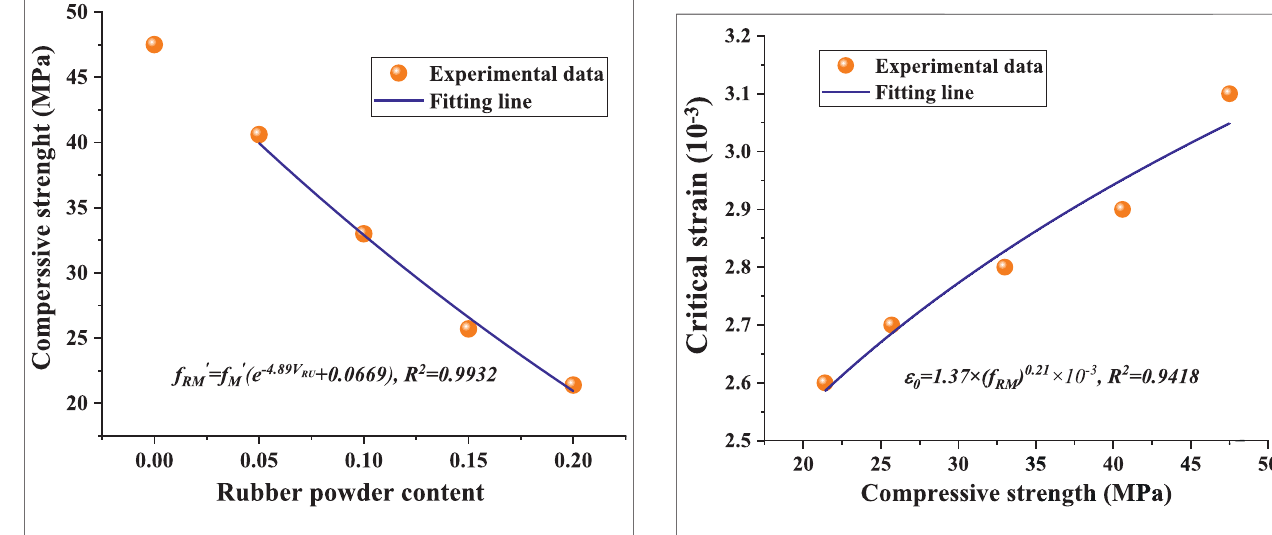
FIGURE 7 | Effect of rubber content on the modulus of elasticity. FIGURE 8 | Effect of rubber content on the critical